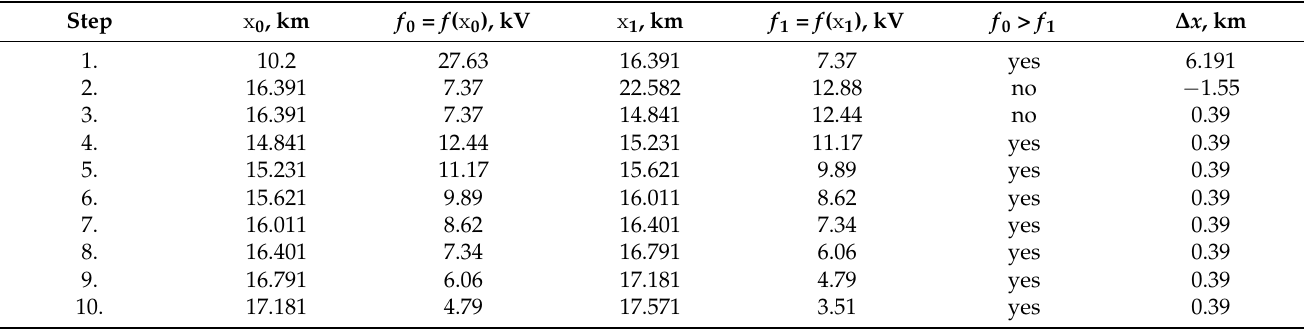
Table 1. An example of the FL implementation on OHPLs based on the bitwise search